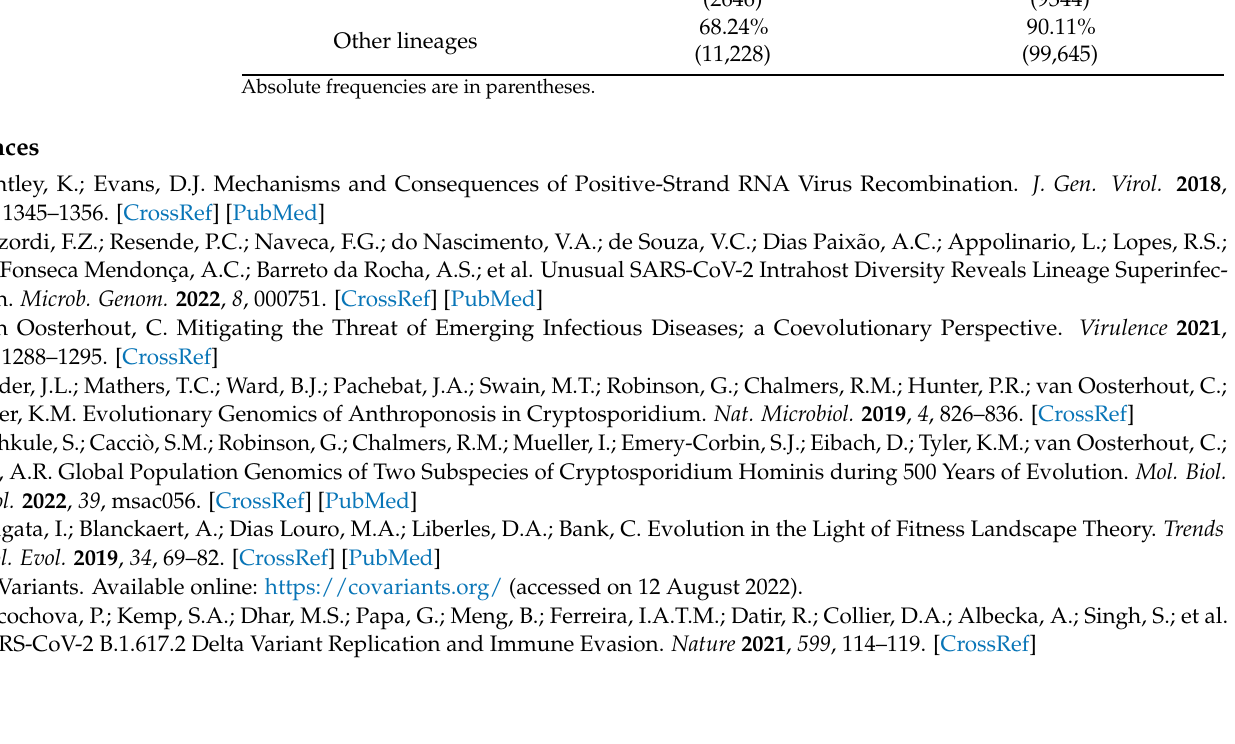
Absolute frequencies are in